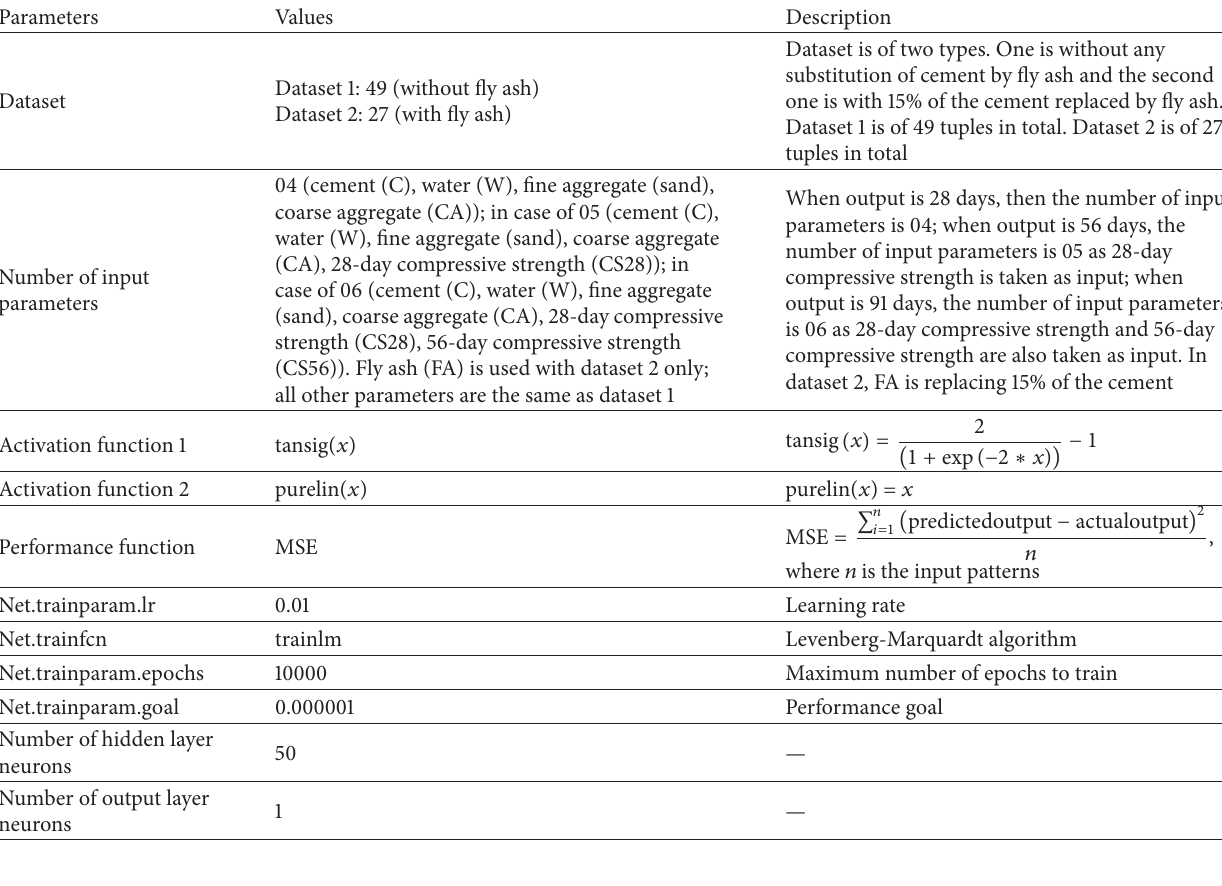
Table 5: Architecture selected for model 1 (ANN